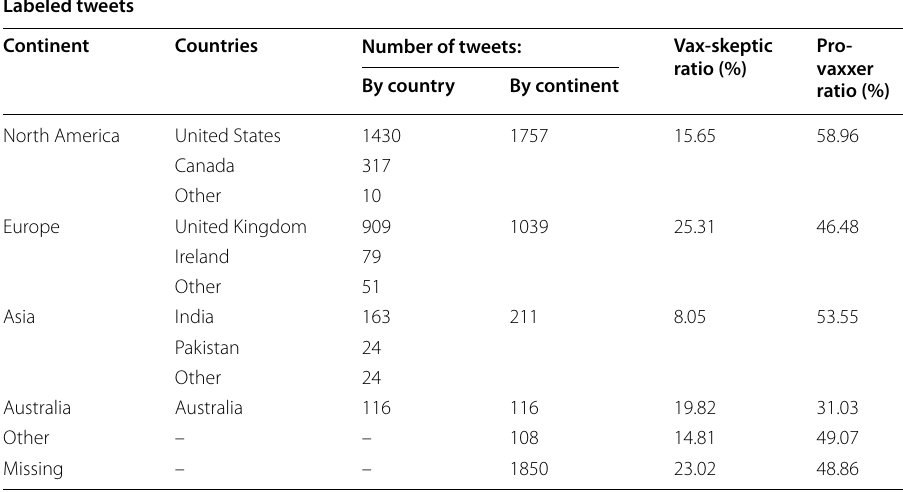
Table 2 Tweet count, vax-skeptic and pro-vaxxer rate by continents for labeled data Labeled tweets